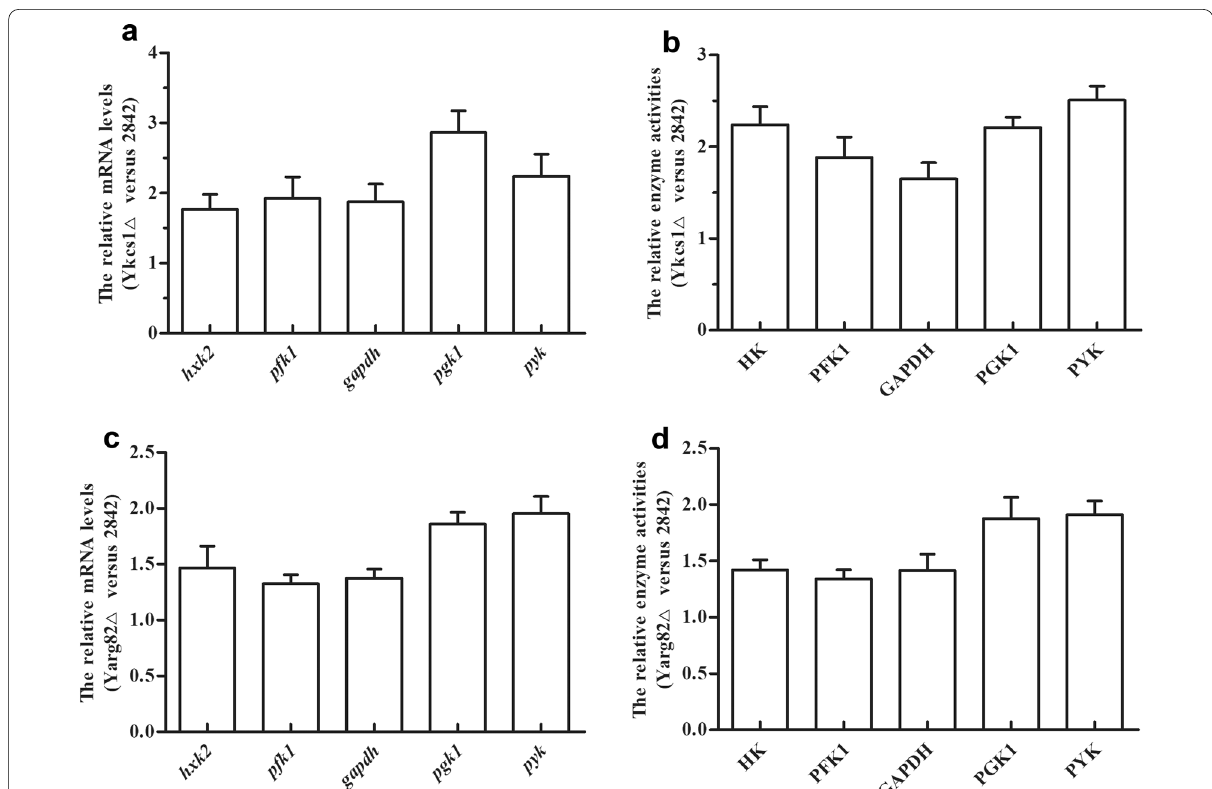
Fig. 3 Deletion of kcs1 and arg82 increased the expression levels of several glycolytic genes and enzyme activities in yeast. a The relative expression levels of hxk2 , pfk1 , gapdh , pgk1 and pyk of the kcs1 deletion strain; b The relative activities of enzymes HK, PFK1, GAPDH, PGK1 and PYK of the kcs1 deletion strain; c The relative expression levels of hxk2 , pfk1 , gapdh , pgk1 and pyk of the arg82 deletion strain; d The relative activities of enzymes HK, PFK1, GAPDH, PGK1 and PYK of the arg82 deletion strain. Error bars correspond to standard error of mean (SEM) of the biological replicates